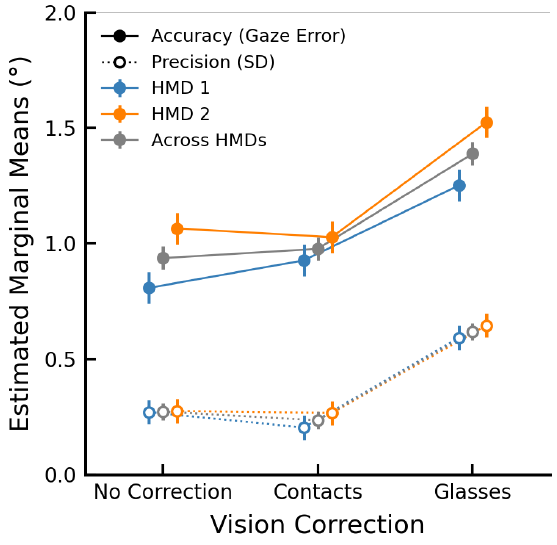
Figure 6. Estimated marginal means resulting from linear models on aggregated session data, each comparing the effects of vision correction and HMD. Model results are shown for accuracy (mean gaze error; filled markers) and precision (SD; open markers). Error bars indicate ±1